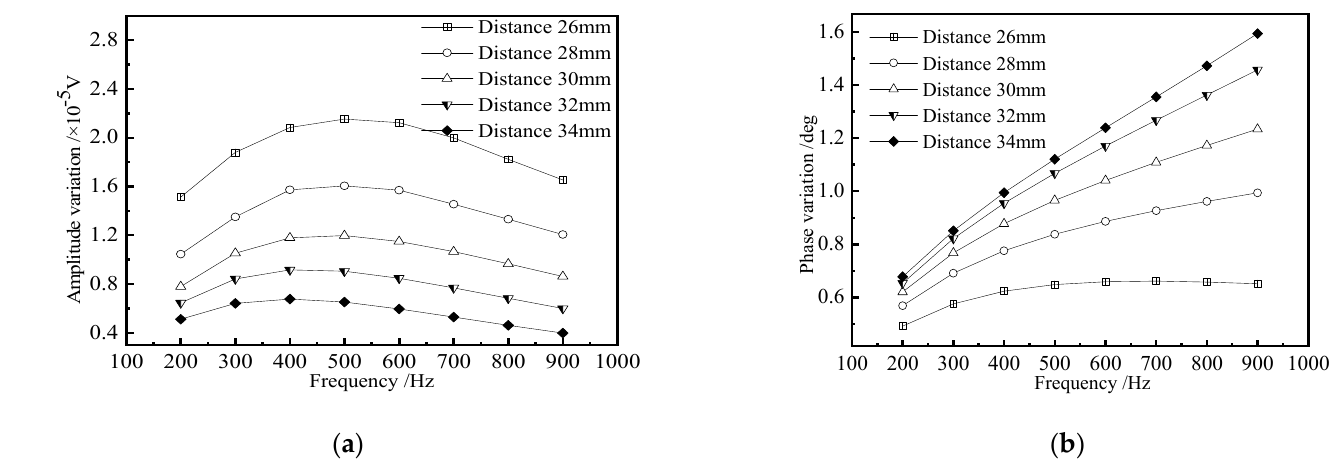
Figure 12. The influence of the excitation/detection coil spacing on the detection signal. ( a ) Detection signal amplitude; ( b ) Detection signal phase.